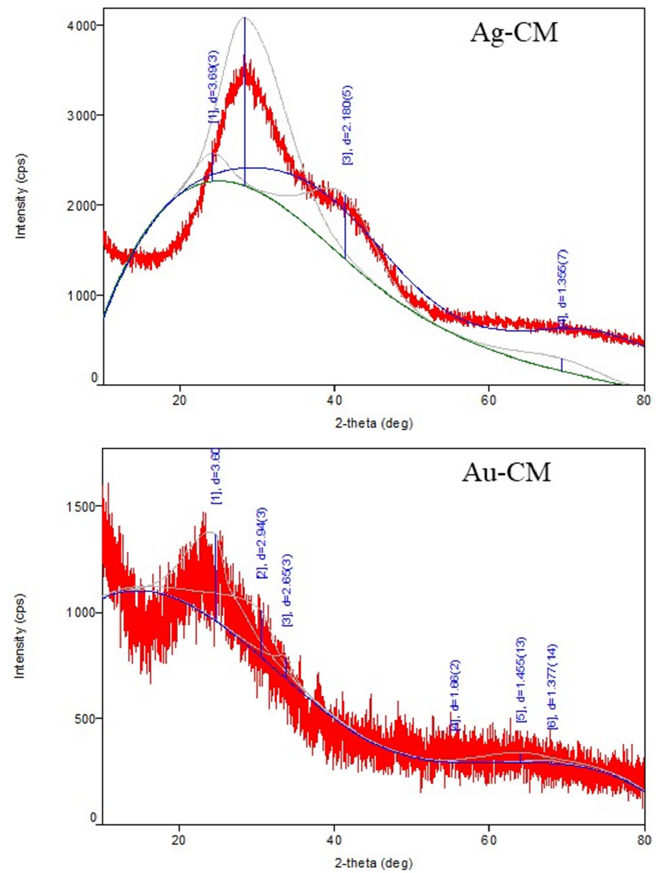
Figure 5. XRD (X-ray powder diffraction) analysis for silver and gold nanoparticles biosynthesized with Cornus mas fruit extract as source of reducing and capping agents.